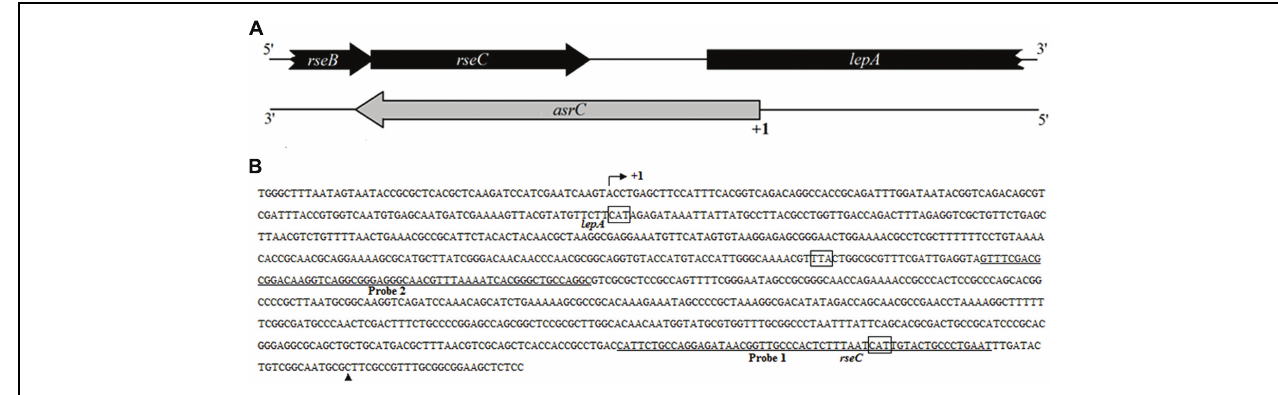
FIGURE 1 | Schematic representation and sequence analyses of asrC . (A) Genomic location of asrC . Black arrows, location of rseB , rseC, and lepA genes; gray arrows, position of asrC . (B) Sequence analysis by RACE of the AsrC. Bent arrow, transcription start site; + 1 and (cid:2) , experimentally determined transcription start site and transcription stop site of the asrC , respectively; underlined sequence, two different positions of oligonucleotide probes used for Northern hybridization for AsrC expression.